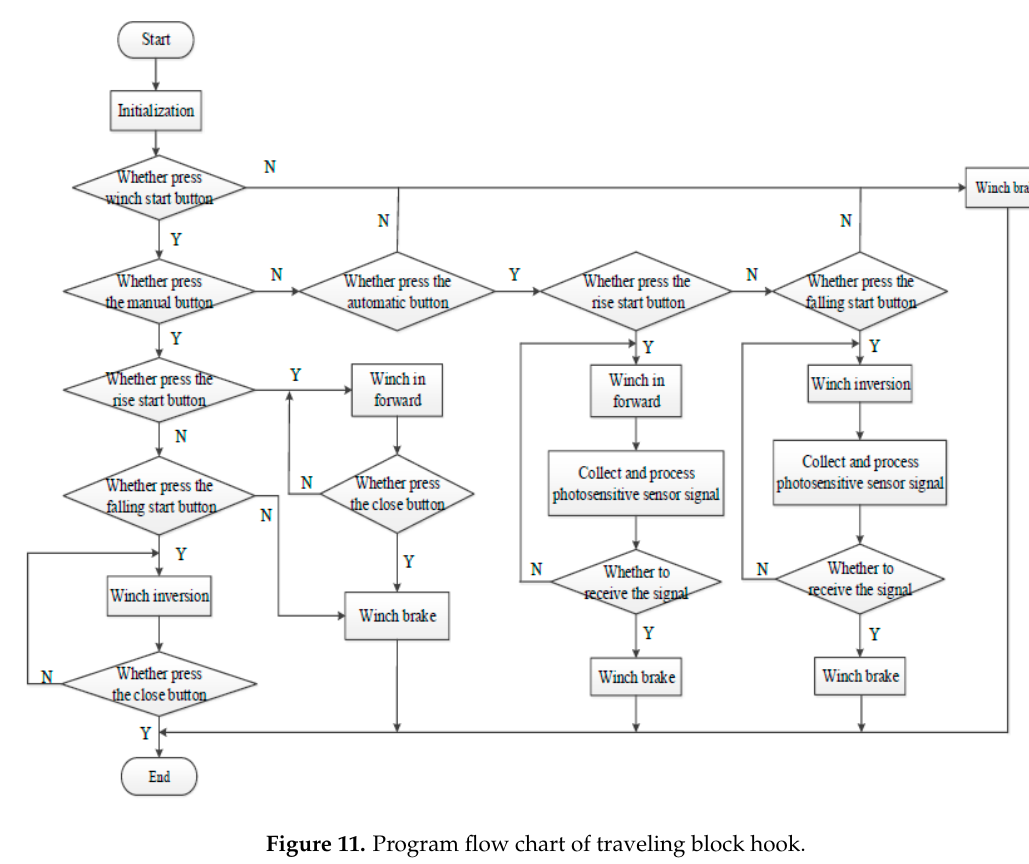
Figure 11. Program flow chart of traveling block hook.